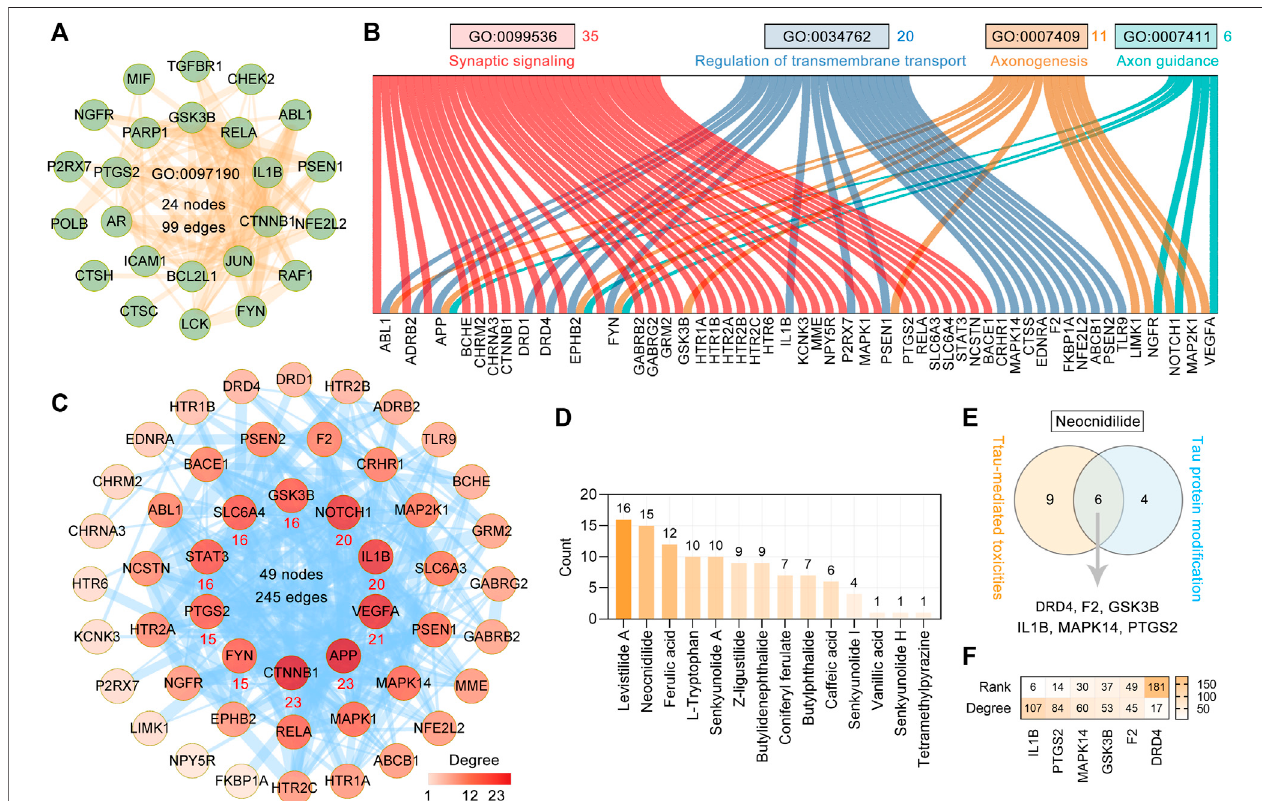
FIGURE5| Majoreffects ofCRmain bioactive phytochemicalson tau-mediatedtoxicities. (A) ThePPInetworkof24CRtargets involved intheapoptotic signaling pathway (GO: 0097190). (B) Sankey diagram of CR targets involved in synaptic signaling (GO: 0099536), regulation of transmembrane transport (GO: 0034762), axonogenesis (GO: 0007409), and axon guidance (GO: 0007411). (C) The PPI network was constructed for 50 targets of CR associated with tau-mediated toxicities. Thedarkerthenodecolor,thehigherdegreeitrepresents.Thethicknessoftheedgedenotesthecombined score.Therednumber belowthenoderepresents the top 10core targets ranked bydegree. (D) CR phytochemicals involved in tau-mediated toxicities ranked according tothe numbers of their targets. (E) Neocnidilide acts in both tau modi fi cation and tau-mediated toxicities via DRD4, F2, GSK3B, IL1B, MAPK14, and PTGS2. (F) In the PPI network of 376 CR targets, the degree value ranking of the six targets associated with (E)